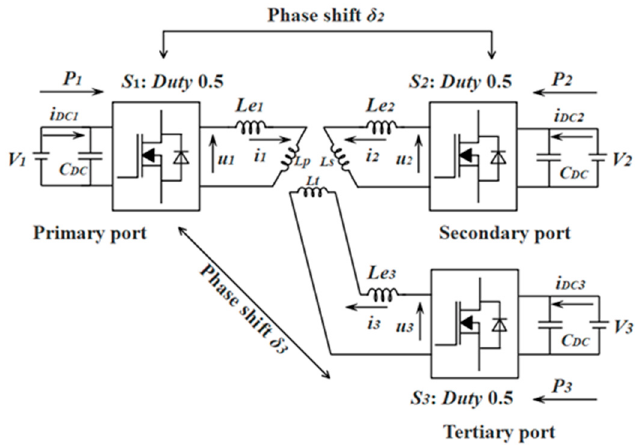
Figure 4. Phase-shift patterns of the TAB converter.